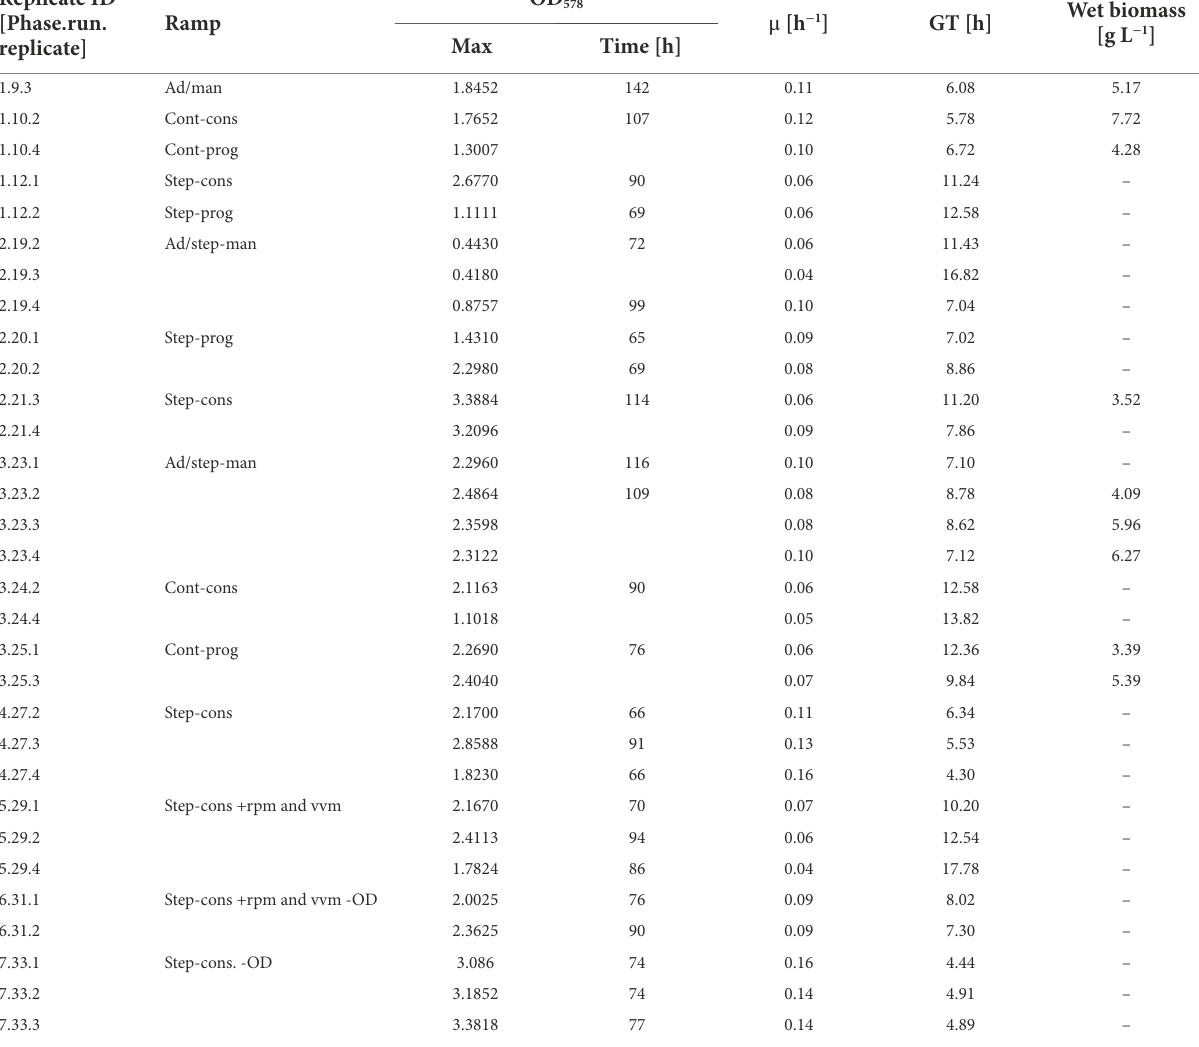
TABLE 3 Comparison of growth parameters from experiments with 1.5 L reactor cultures. *** Replicate ID